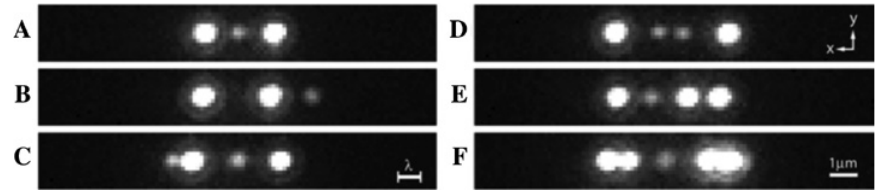
Figure 3: Assisted trapping of nanoparticles using optical binding forces. Two gold nanoparticle sizes (200 nm and 10 nm) trapped in water and aligned in a standing wave optical line trap (SWOLT), using a 1064 nm wavelength laser at approximately 200 nm above a reflecting coverslip surface. Individually, smaller particles exhibit large fluctuations along the x -axis; using the larger particles as anchors, the small particles become confined due to the strong optical binding forces. Scale bar λ = 800 nm. Reproduced with permission from [51].